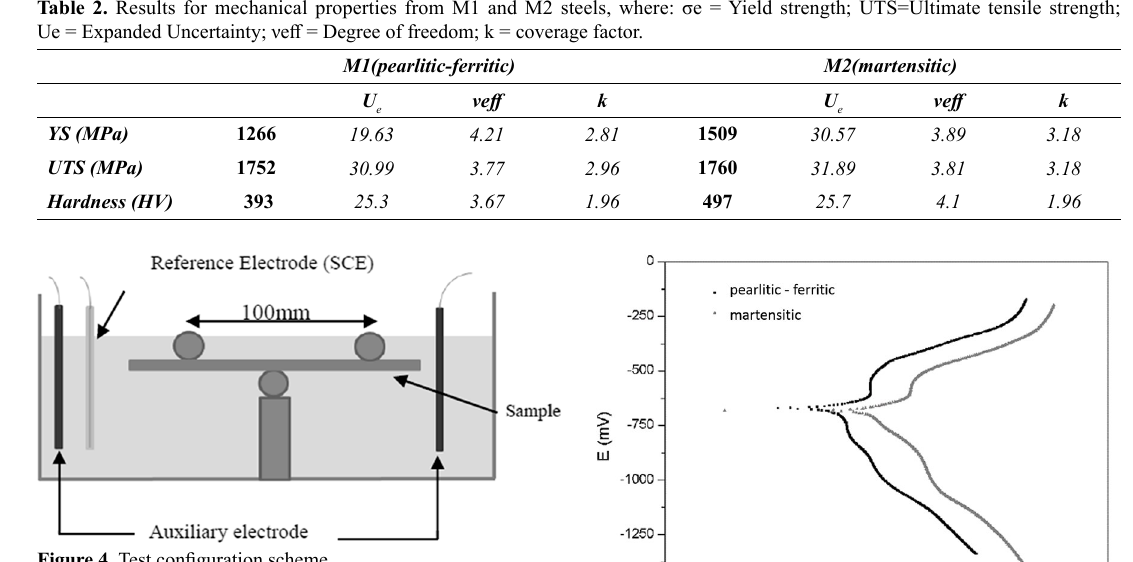
Figure 4. Test configuration scheme.